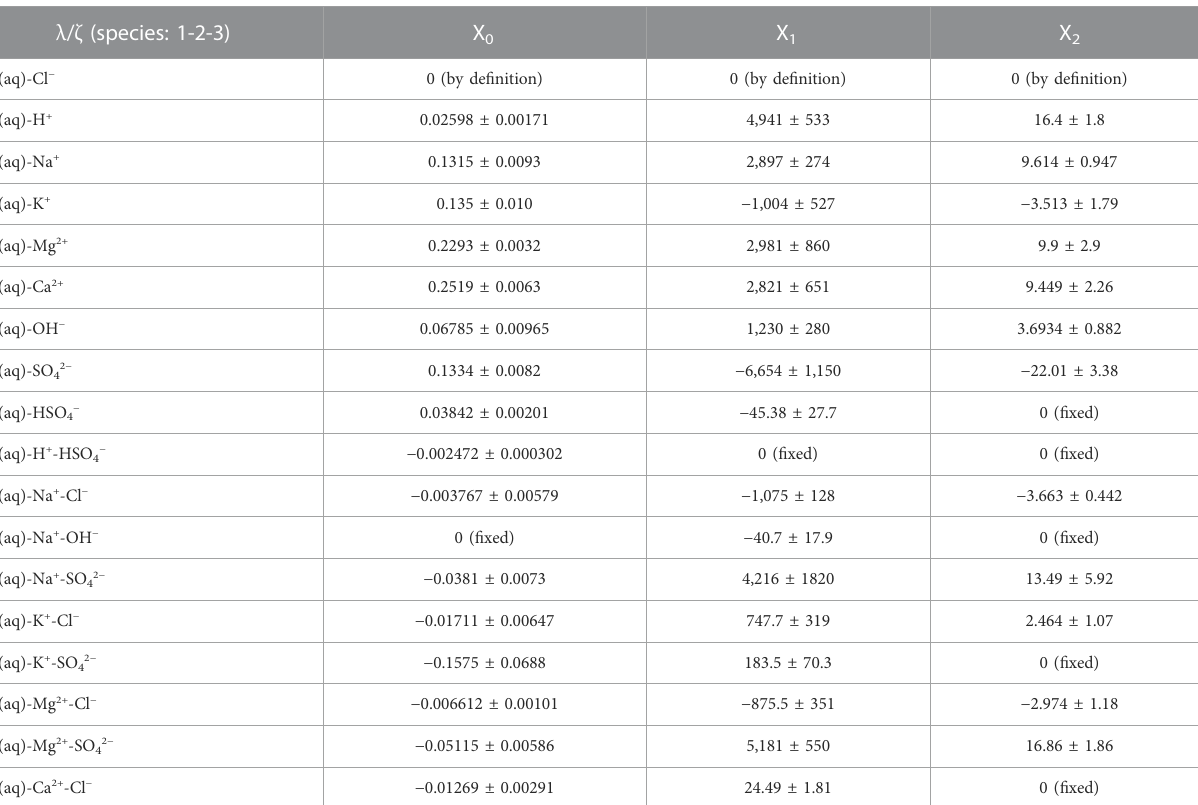
TABLE 9 Parameters for the temperature dependency function of the binary and ternary interaction coef fi cients ( λ , ζ ). The uncertainty information refers to one standard deviation. λ / ζ (species: